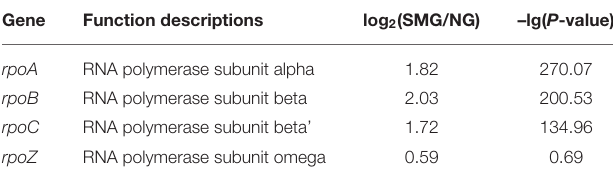
TABLE 3 | Transcription changes of RNA polymerase genes. Gene